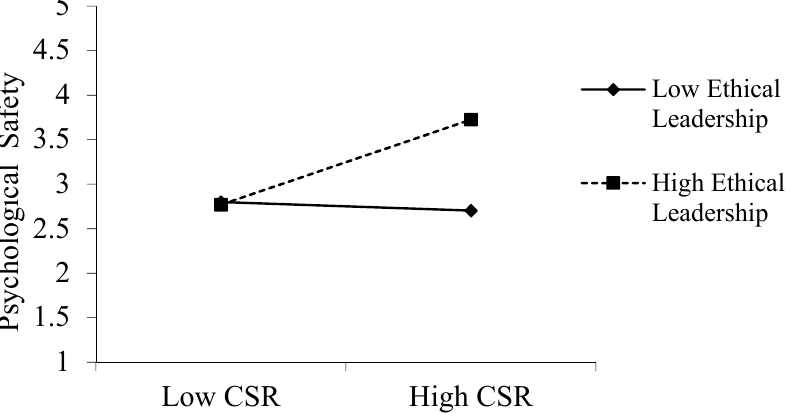
Figure 4. Moderating effect of ethical leadership in the corporate social responsibility (CSR)– psychological safety